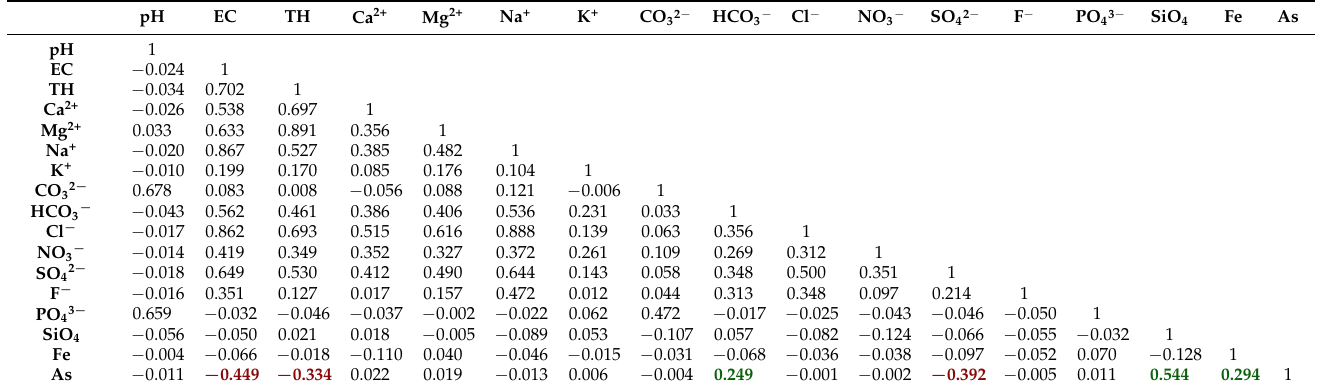
Table 4. Correlation of arsenic with groundwater quality